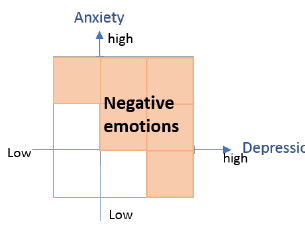
Figure 4 Conditional Combinations